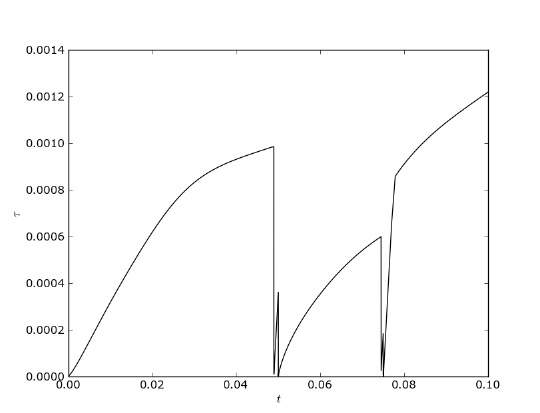
Figure 5. The time-history of the time step: δ = 0 . 1, N = 569.